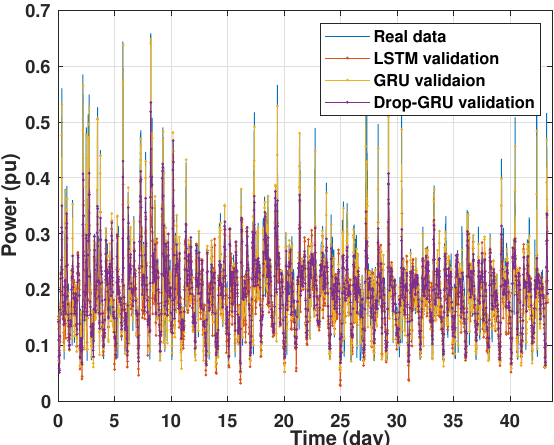
Figure 12. Training and validation for 15 days forecasting.